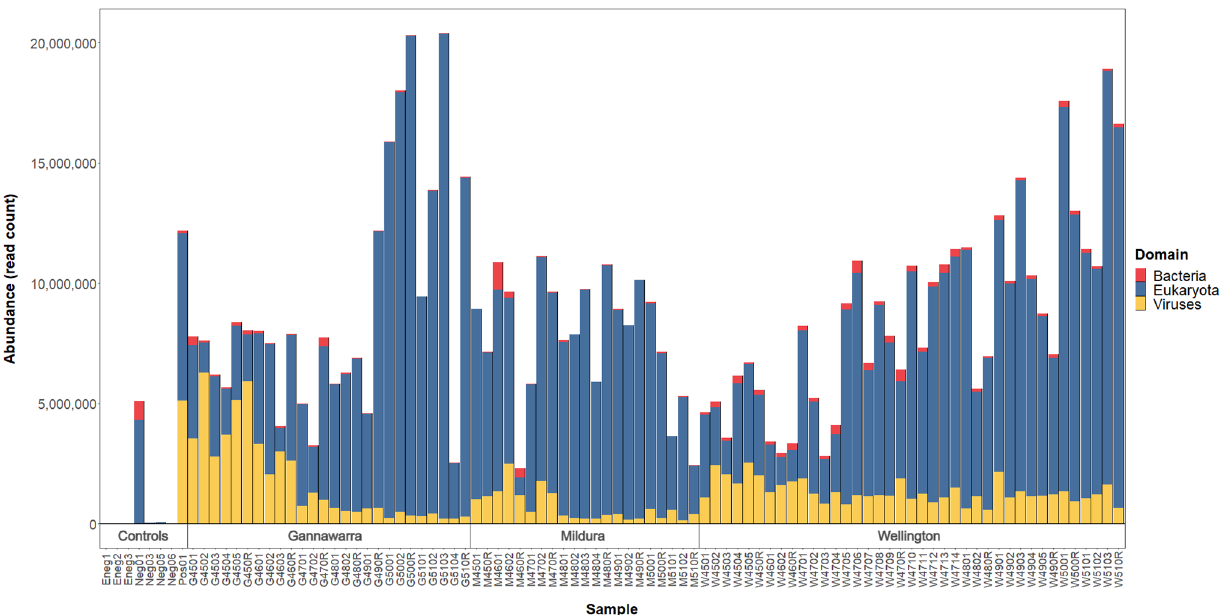
Figure 3. Domain-level taxonomic composition of the individual mosquito trap samples and control samples. Abundance is based on read counts for taxonomically classified contigs produced by de novo assembly. Archaea taxa were excluded from the figure due to their low abundance.